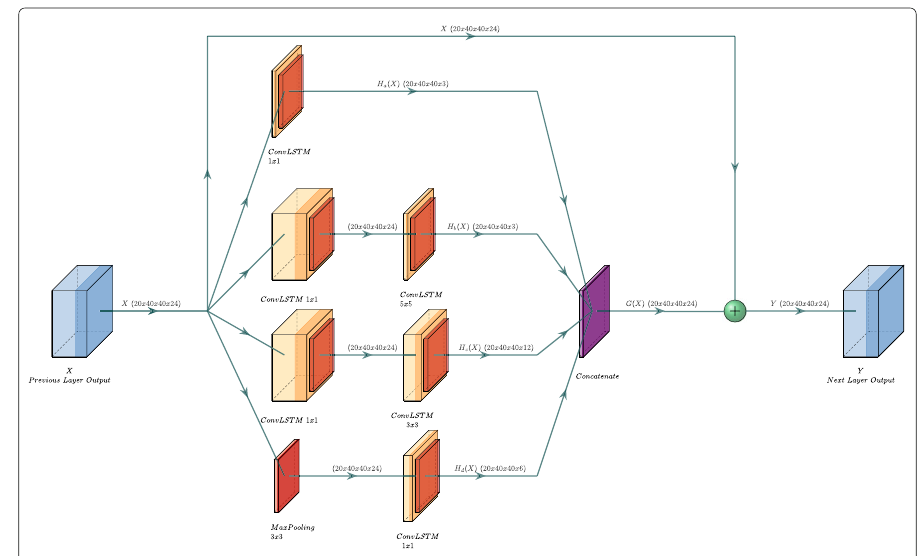
Fig. 4 Proposed ResIncConvLSTM structure labeled with data tensor dimensions and corresponding equations